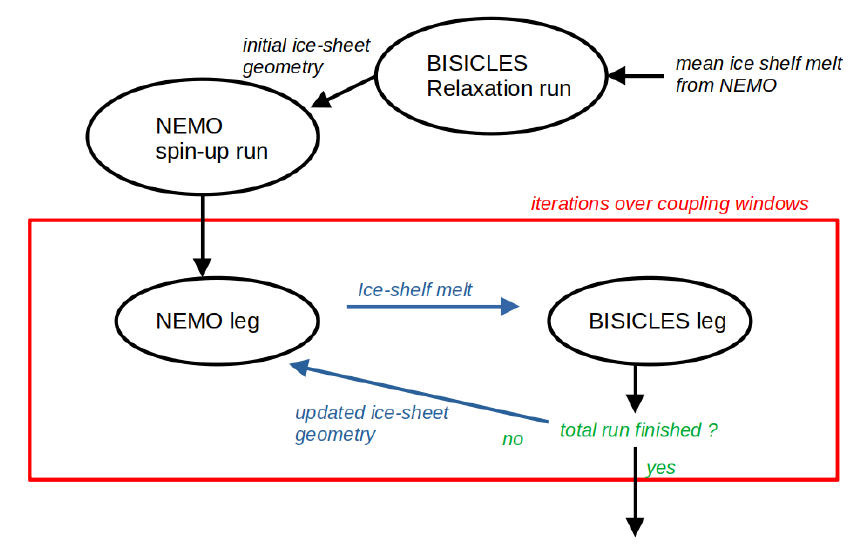
Figure 2. NEMO–BISICLES coupling procedure. The red box represents the coupling loop. Arrows depict the data exchanged between NEMO and